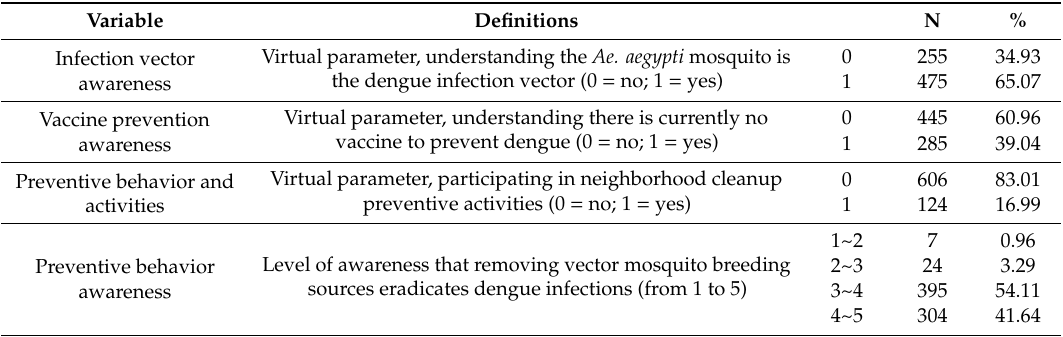
Table 4. Statistics of dengue